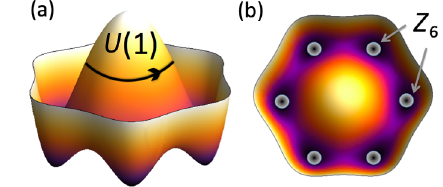
FIG. 2. Mexican-hat potential-energy surface of the hexagonal manganites. At high energy (the peak of the hat), the energy is independent of the angle of trimerization, and the system has continuous U ð 1 Þ symmetry. At lower energy (in the brim of the hat), six of the trimerization angles become favorable (white circles), and the symmetry reduces to the sixfold discrete sym- metry described by Z 6